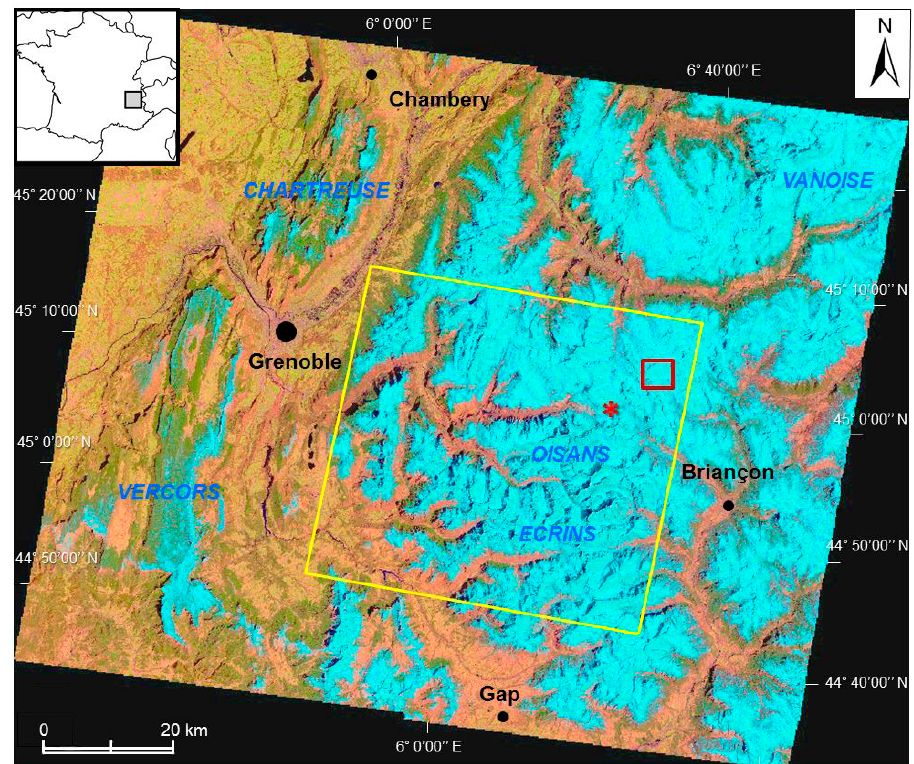
Figure 1. Location of study area, showing the overall SPOT-4 (Take 5) extent and the reduced SPOT-5 extent in yellow , which covers the Oisans massif and the Ecrins National Park. The red star shows the Figure 2 location and the red inset shows the “Massif des Cerces” area of Figure 5. The background image is a visible and infrared color composition ( green , near infra-red and short-wavelength infrared channels) from a SPOT-4 scene acquired on 14 April 2013, with snow cover shown in blue . © CNES-Cesbio .